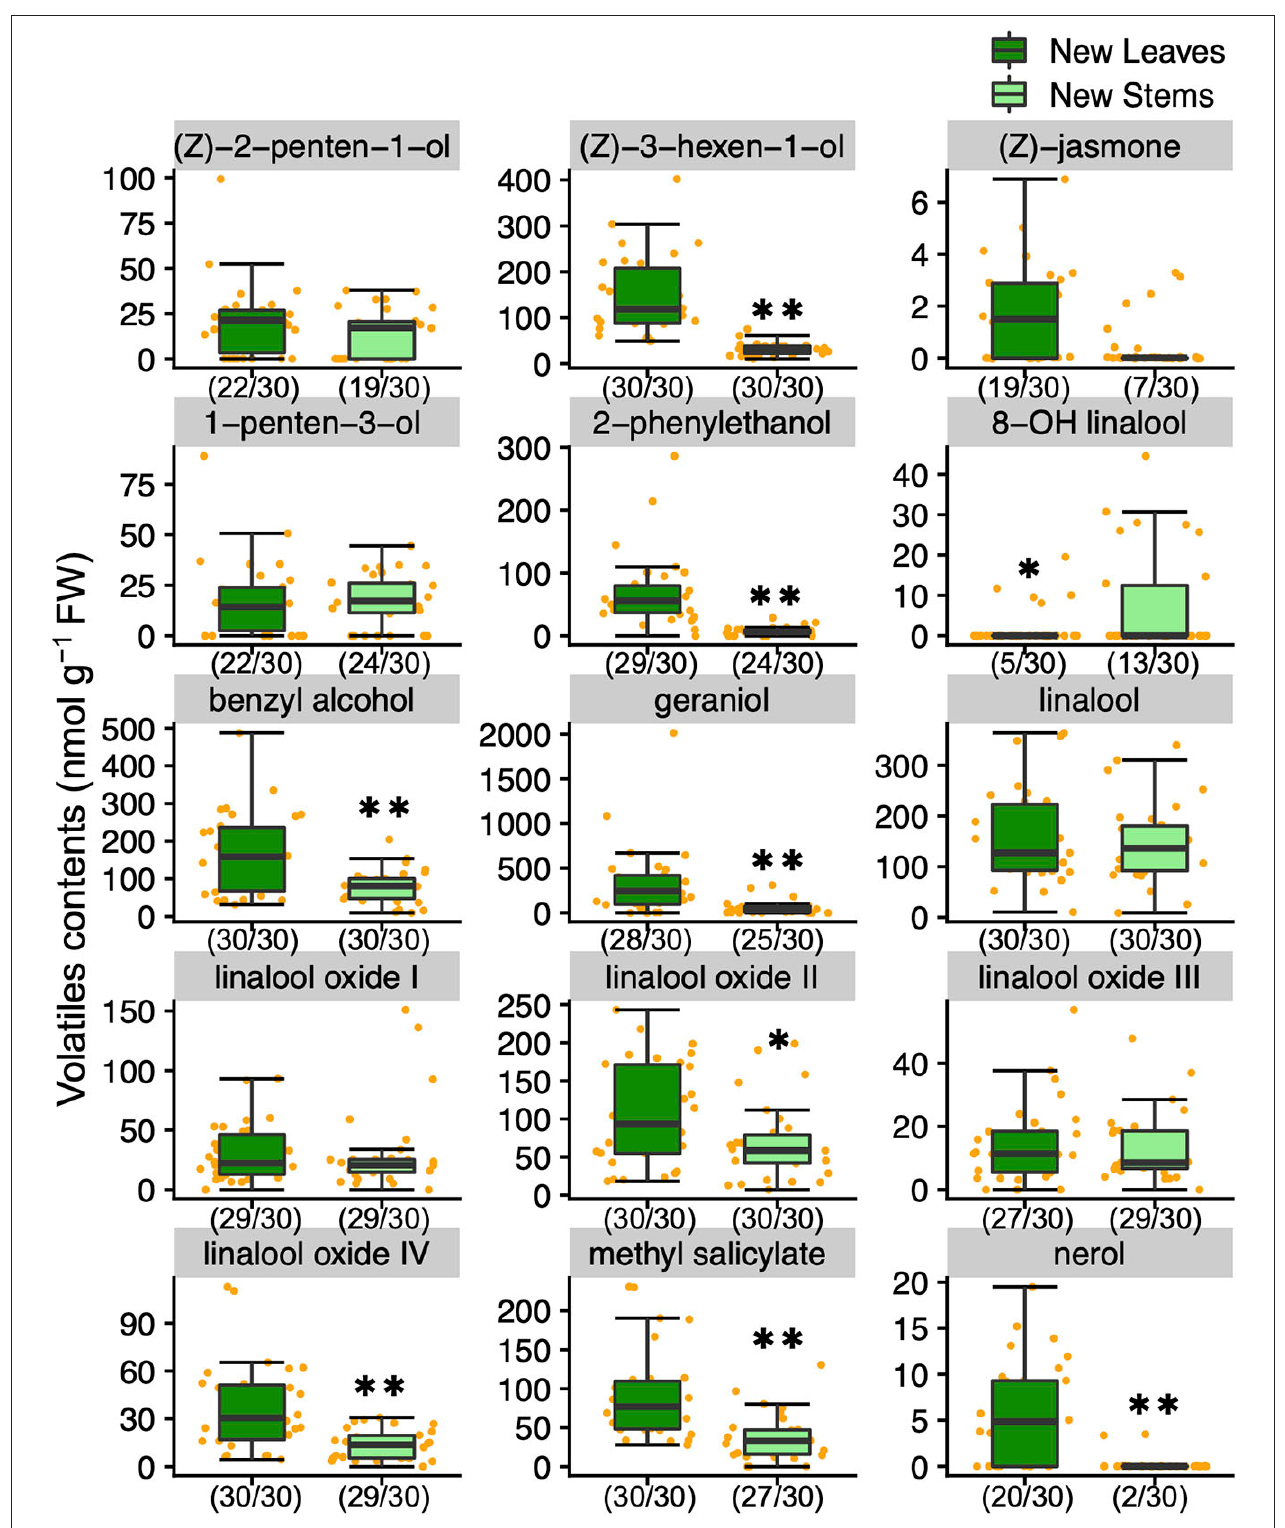
FIGURE 1 | Boxplots of volatiles contents in new leaves and stems of the tea accessions. Single and double asterisks indicate P < 0.05 and P < 0.01, respectively (Welch’s t-test). Orange plots indicate the values of each accession. Left and right numbers in parentheses indicate quantified and analyzed accessions, respectively.